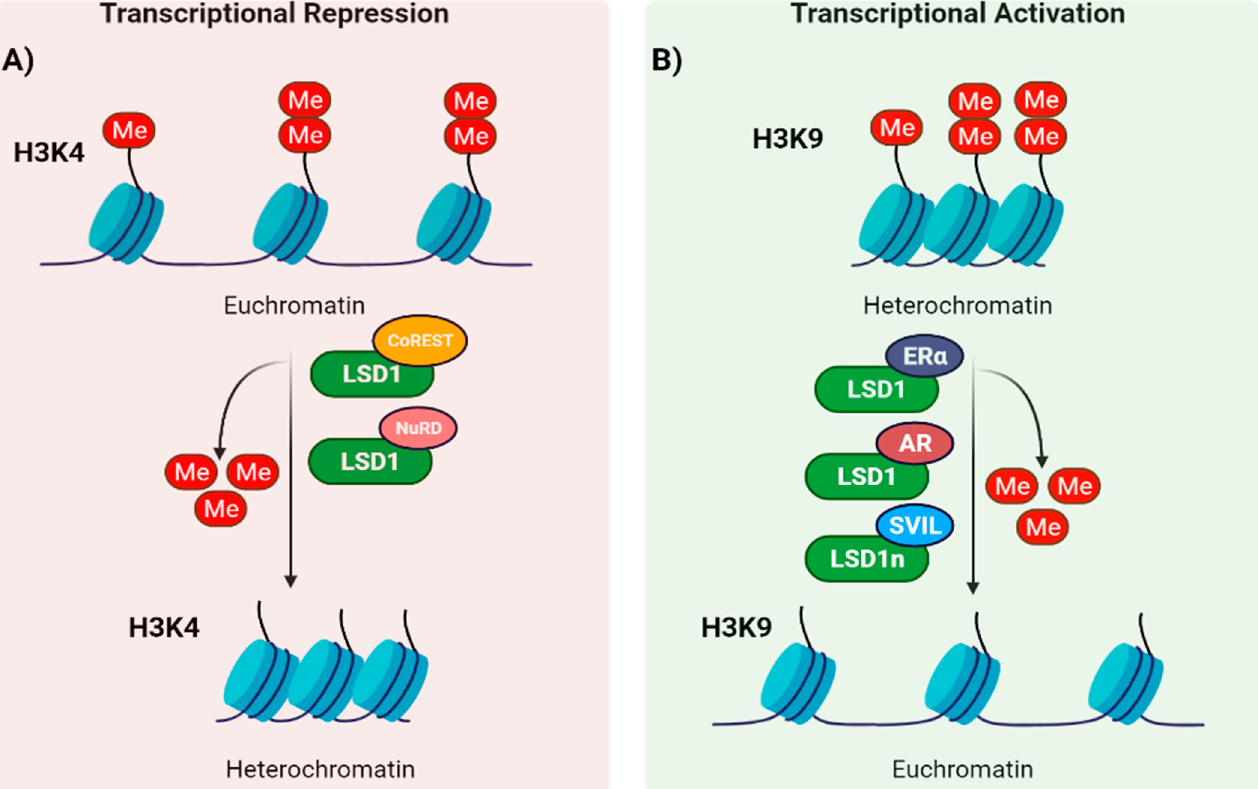
Figure 2. Transcriptional regulation of LSD1 by its demethylation activity on histone substrates. ( A ) LSD1 interacts with CoREST, NuRD and other protein complexes (not shown) to catalyze H3K4me1/me2 demethylation, resulting in transcriptional repression. ( B ) In some cellular contexts, LSD1 can interact with ER α and AR and activate transcription by demethylation of H3K9me2/me1. The isoform LSD1n presents affinity for H3K9 methyl groups through supervillin (SVIL) binding. LSD1-mediated methylation of H4K20me2 is not represented for simplicity.